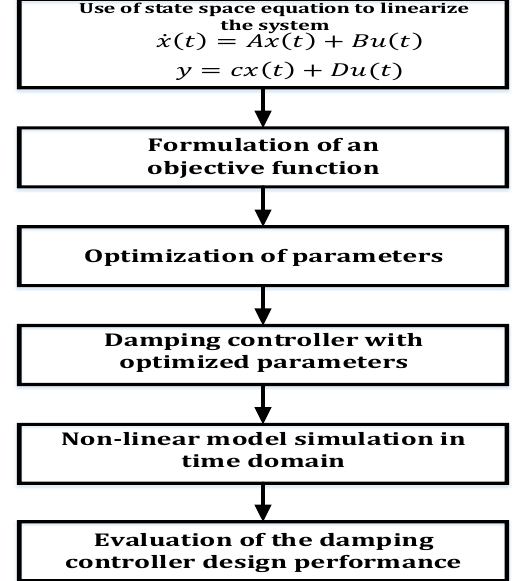
Figure 21. Procedure of trimming and linearization [28].